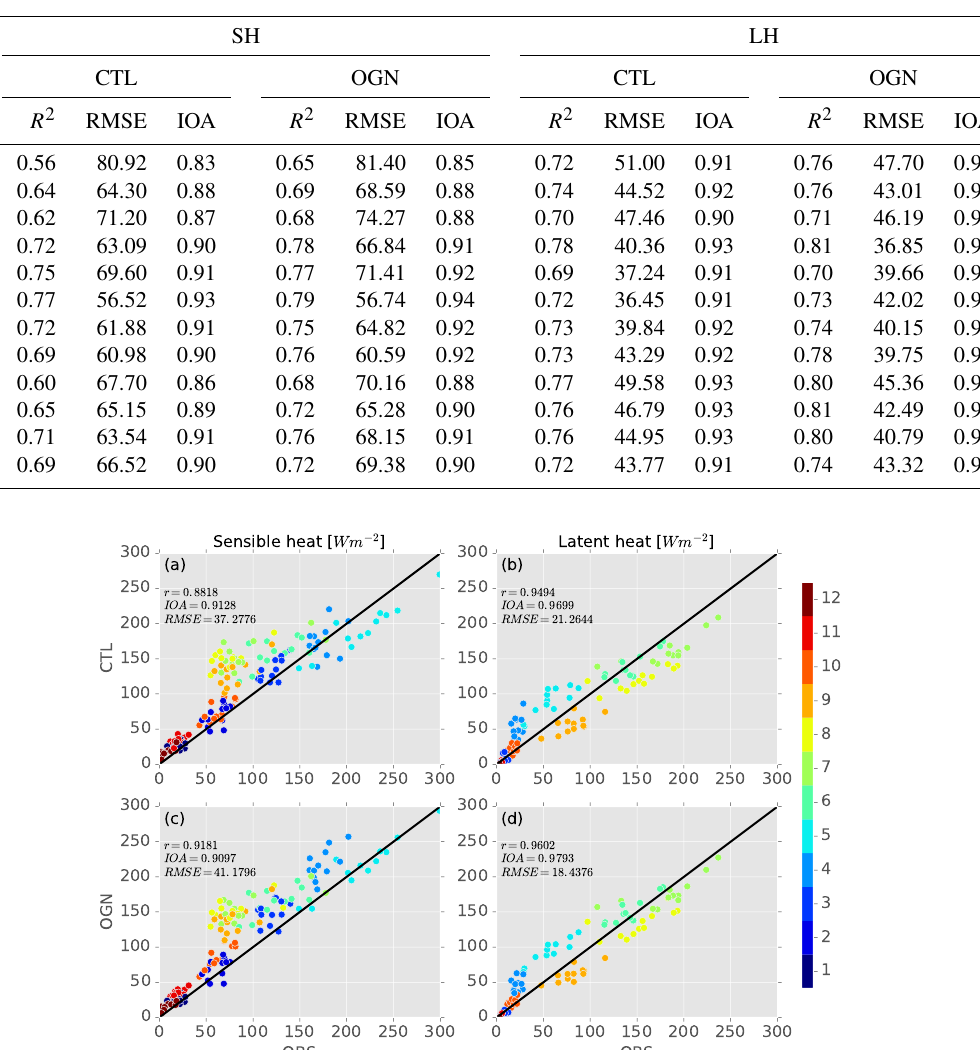
Table 3. Averaged statistical indices for CTL- and OGN-simulated SH and LH compared with the observations for each year (daytime, 08:00–16:00 local time (LT)) ( R 2 : correlation coefficient square; RMSE: root mean square error; IOA: index of agreement).